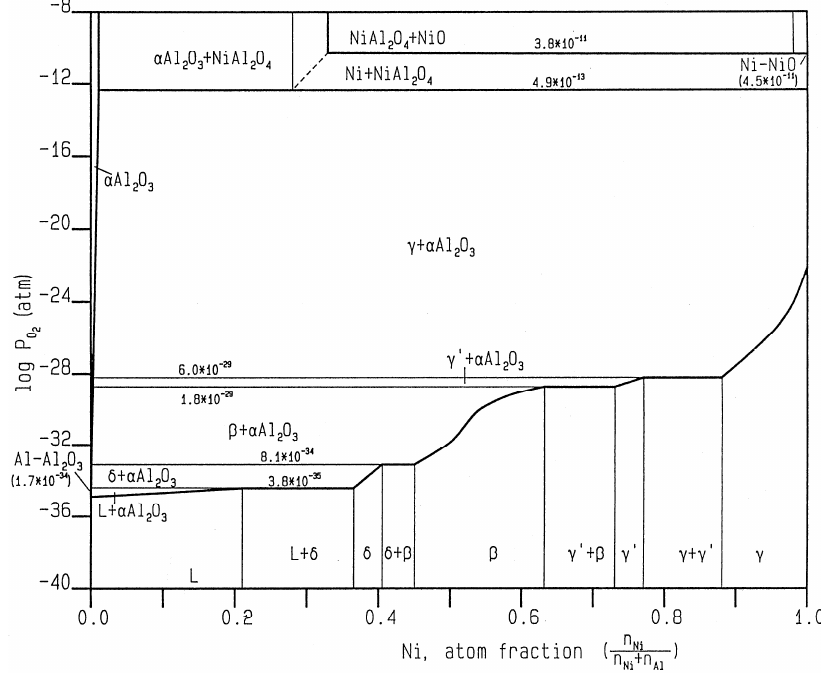
Figure 17. Ni/Al/O phase diagram for 1273K and 1 atm total pressure.